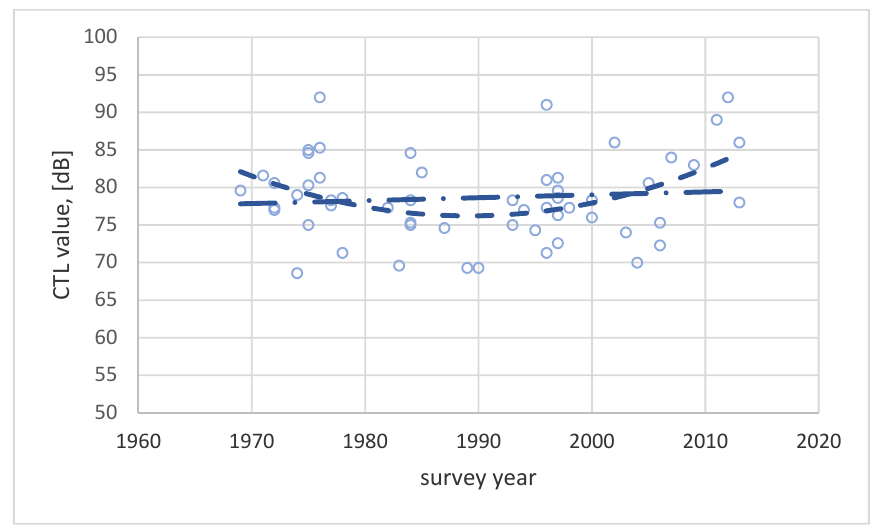
Figure 6. CTL values for 61 surveys on road traffic noise plotted as a function of study year. The two lines show a linear regression function (dash–dotted) and a second order polynomial regression function (dashed).